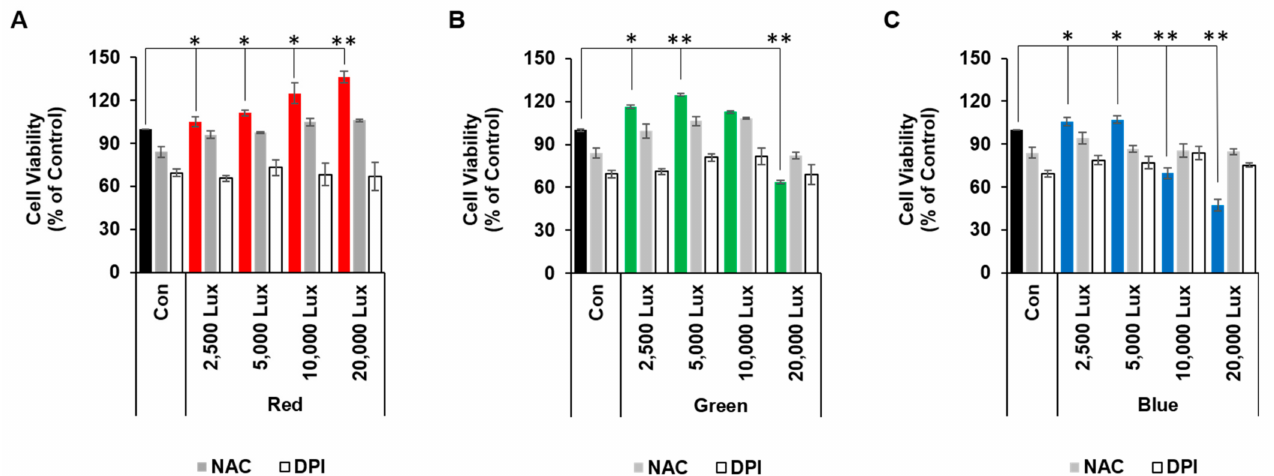
Figure 1. Differential effects of red, green, and blue LED light exposure on the viability of HaCaT cells. HaCaT cells cultured in a 96-well plate were pretreated with or without NAC (10 mM) or DPI (10 µ M) for 1 h prior to exposure with red ( A ), green ( B ), or blue ( C ) LED lights for 1 h. After 24 h, cell viability was quantified by MTT assay ( n = 3, ± SD). * p < 0.01 and ** p < 0.001 vs. control. While red LED at all ranges as well as green and blue LED exposure at 2500 and 5000 lux increased cell viability (Figure 1), green LED exposure at 20,000 lux and blue LED exposure at 10,000 and 20,000 lux decreased cell viability. However, the NAC and DPI treatments improved the decreased cell viability during green LED exposure at 20,000 lux and blue LED exposure at 10,000 and 20,000 lux (Figure 1). Therefore, these results indicated that depending on the intensity and wavelength, LED lights may affect cell viability